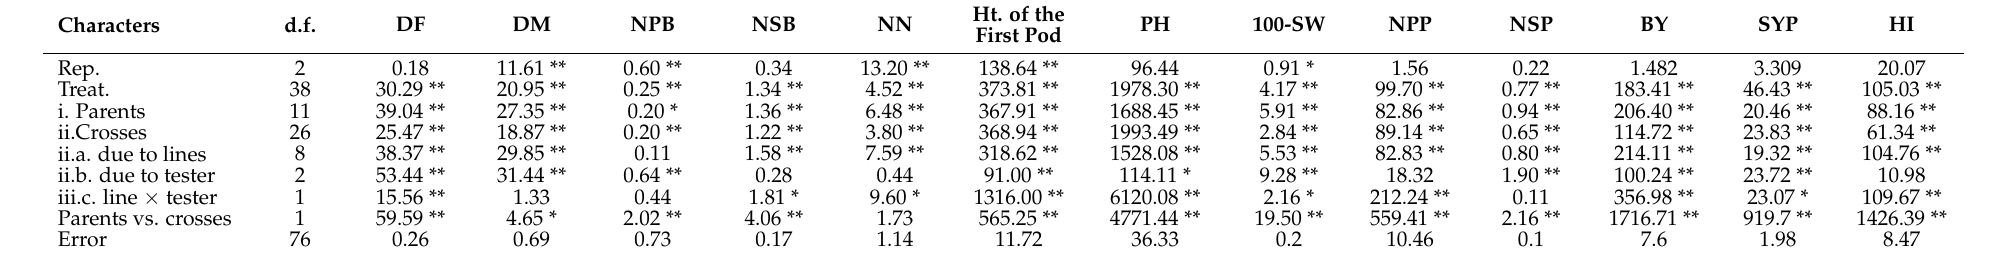
Table 2. Analysis of variance for combining ability in field pea.